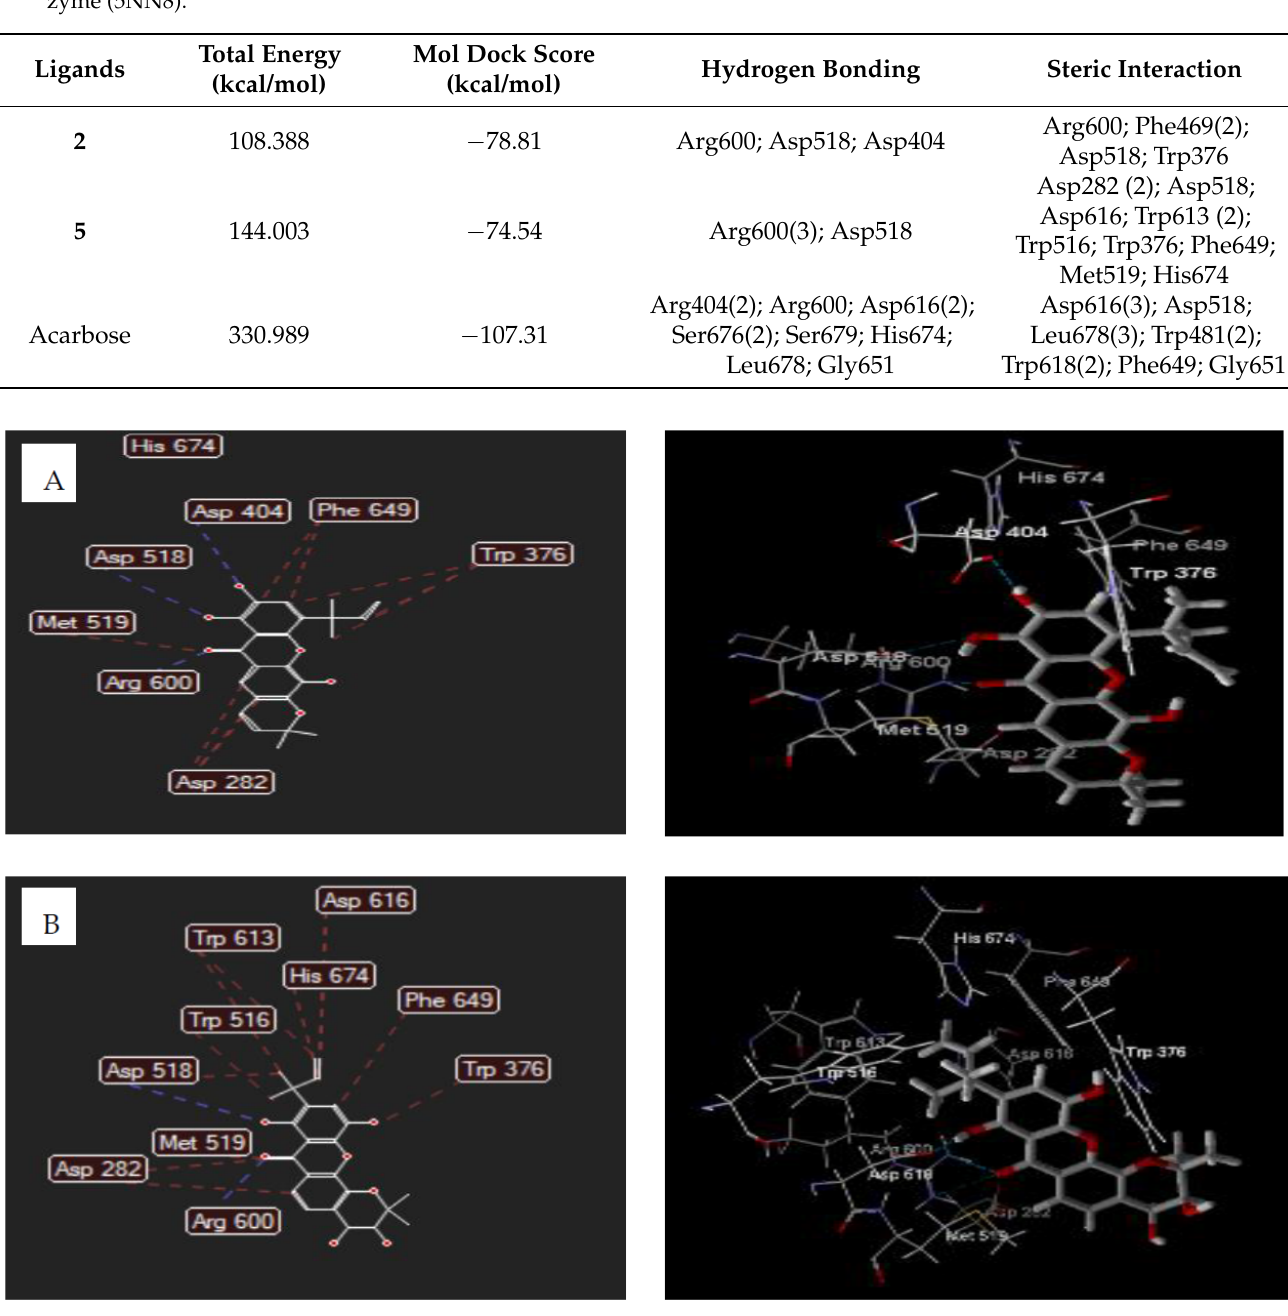
Figure 2. The 2D and 3D interaction of 2 ( A ) and 5 ( B ) with human lysosomal acid-alpha-glucosidase enzyme. Hydrogen bonds were depicted as blue dotted lines while steric interactions were shown as red lines. Carbon atoms were represented in gray, oxygen in red and hydrogen in white.